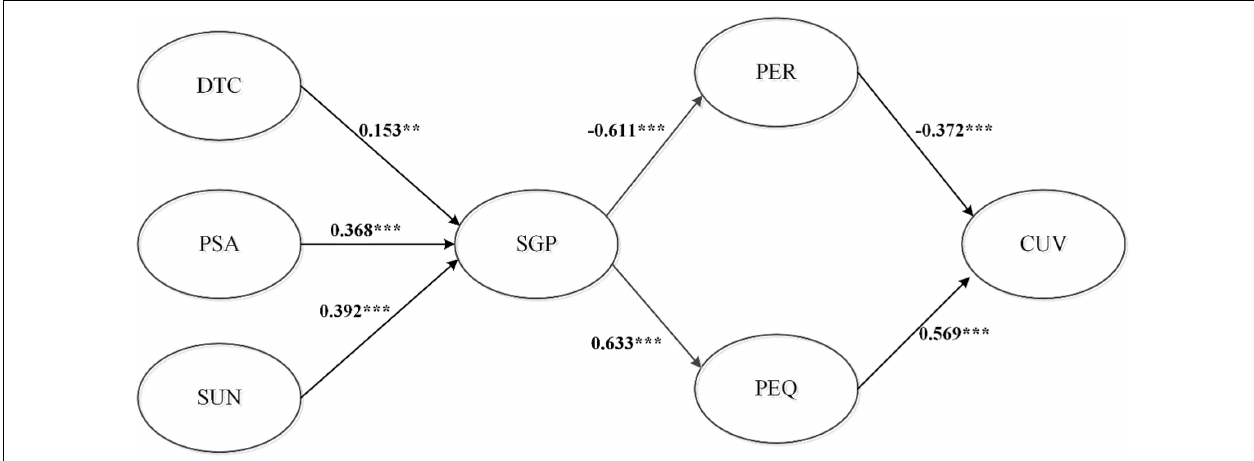
FIGURE 2 | SEM statistic model. Note: *p-value < 0.05; **p-value < 0.01; and ***p-value <